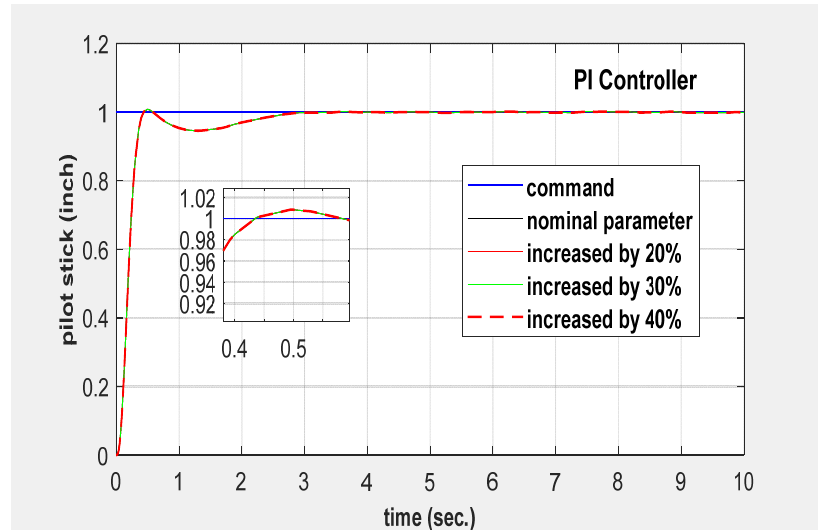
Figure 22. System response based PI with parameters perturbation.